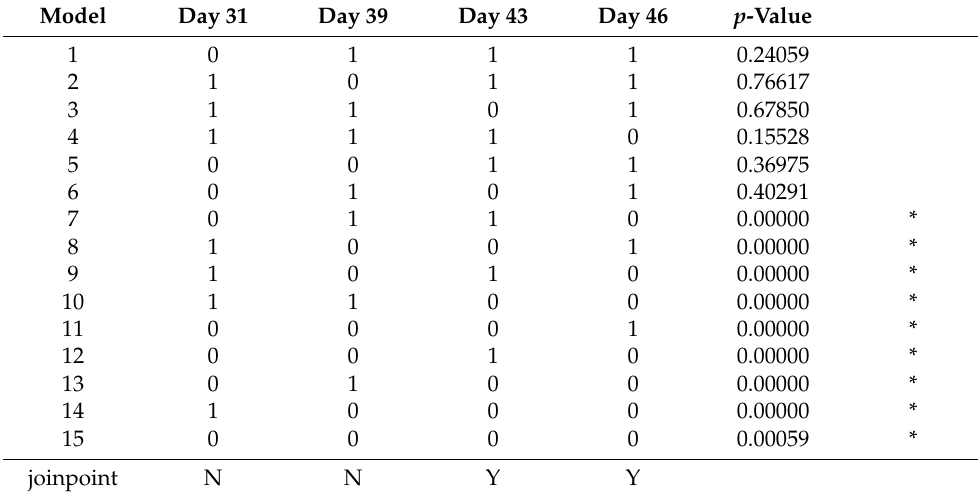
Table A1. Multiple comparisons of the effective reproduction number accounting for the absence of dates of specific event of interventions and the identification of joinpoints during the first wave of coronavirus disease 2019 in Osaka, Japan.